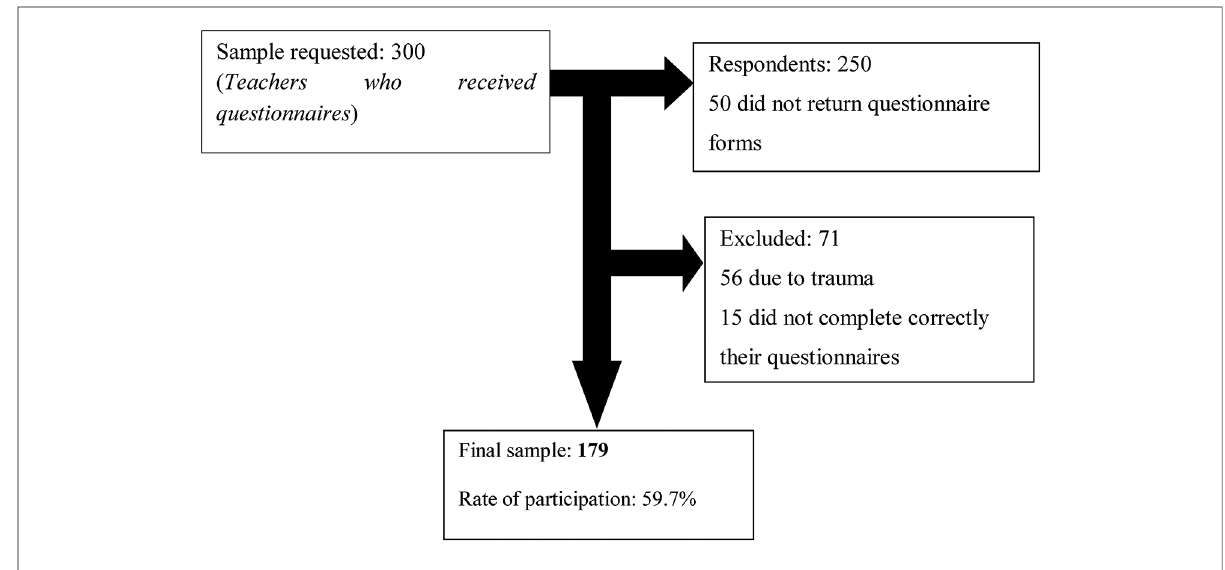
FIGURE 1 Flow charts of